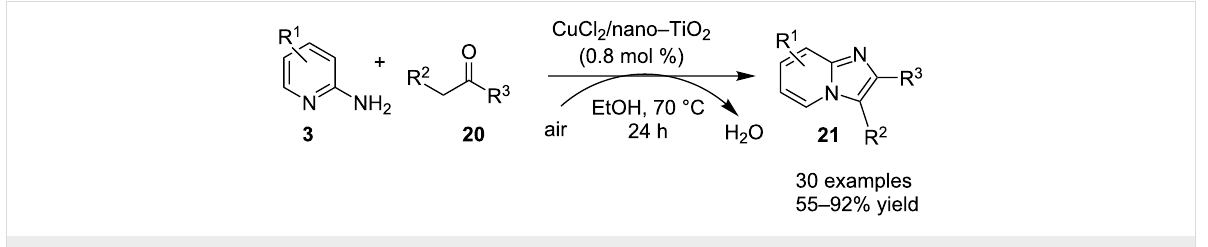
Scheme 7: Heterogeneous synthesis via titania-supported CuCl 2